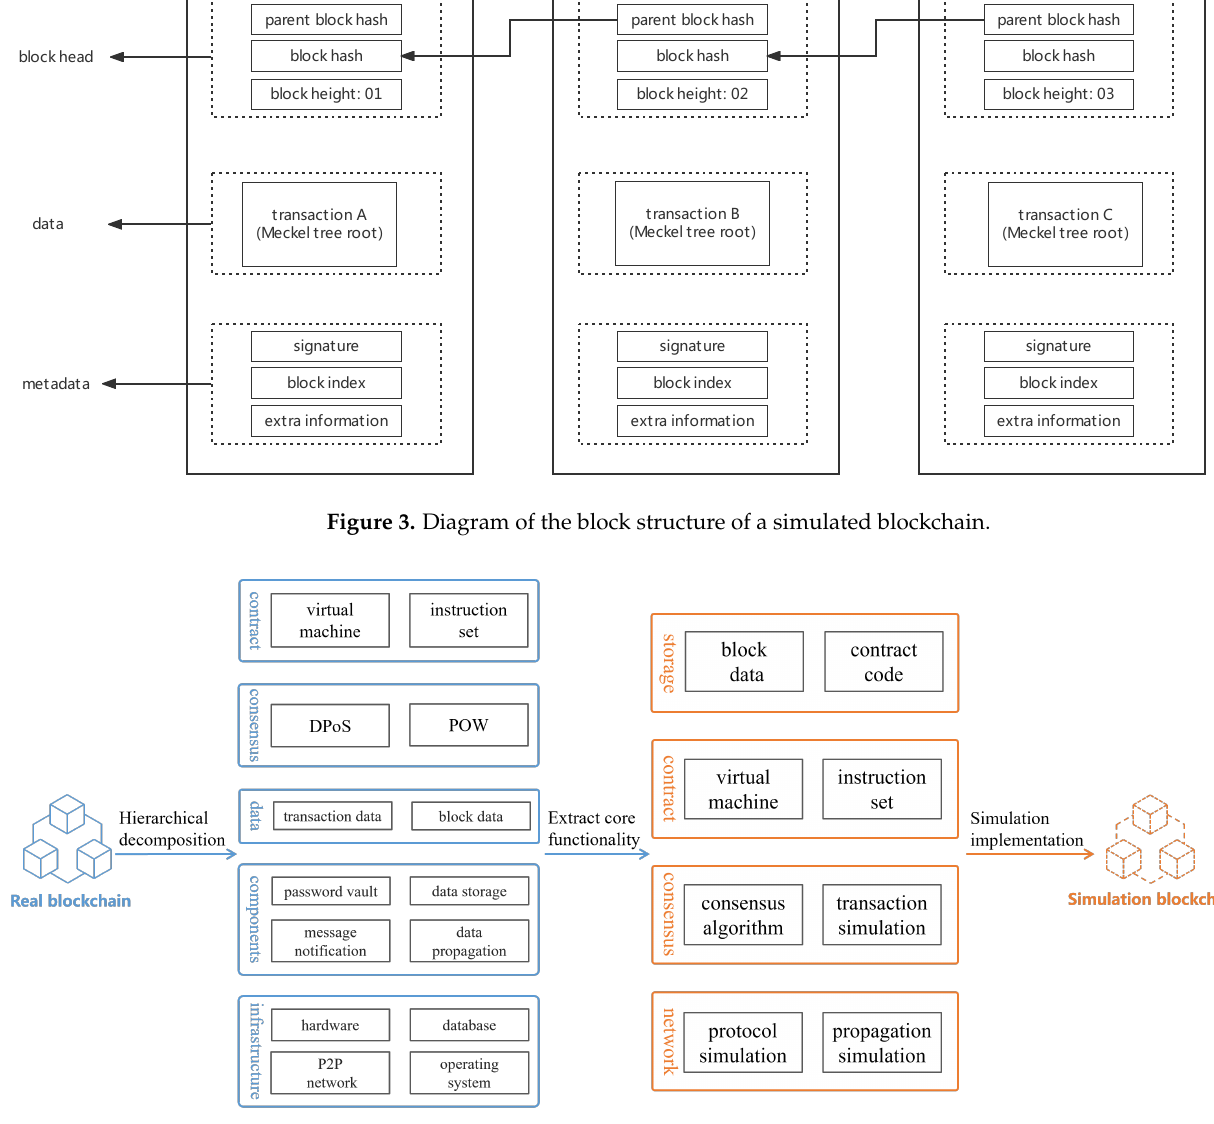
Figure 4. Typical hierarchical division in the blockchain simulation